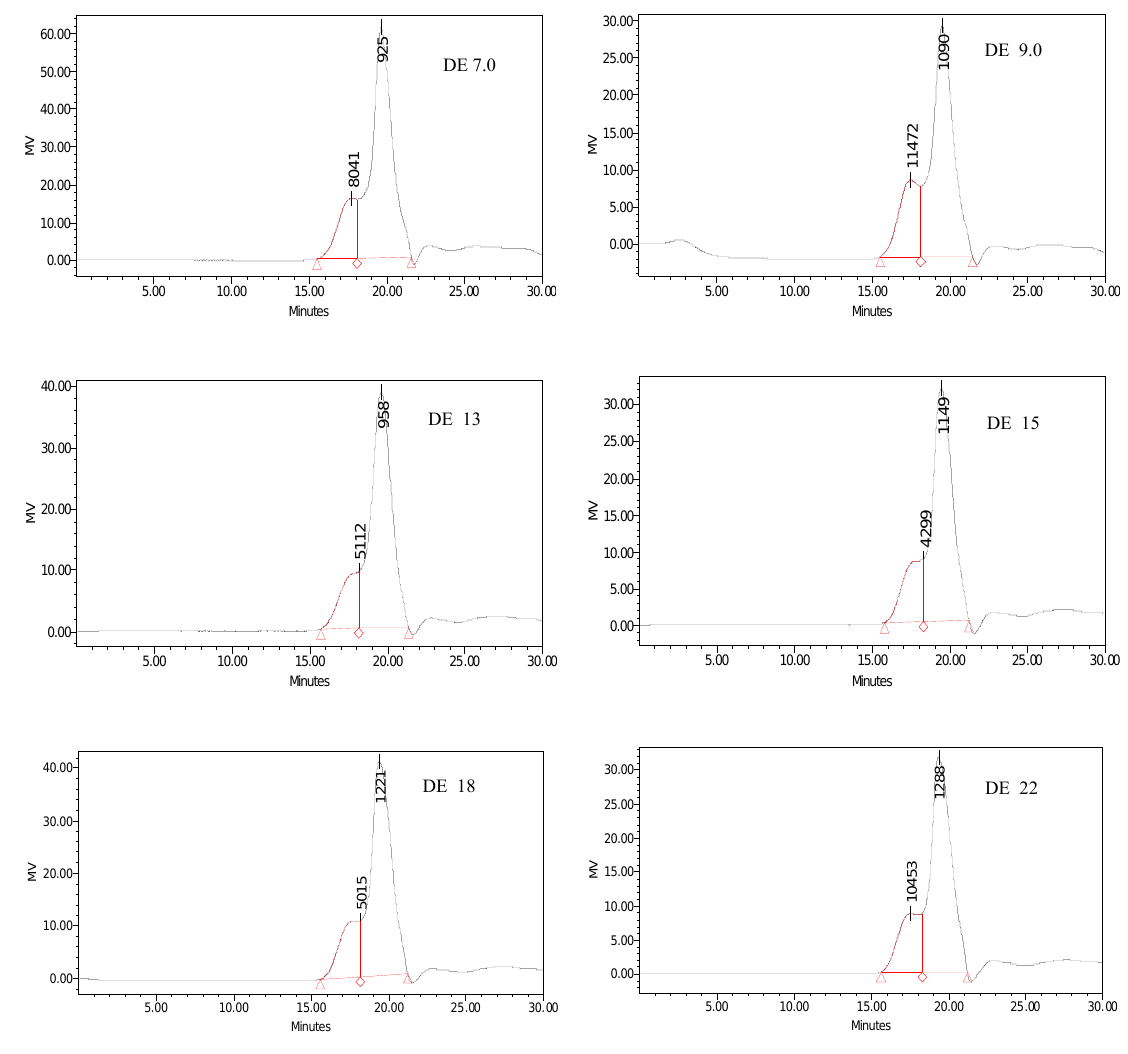
Figure 5. Molecular weight distribution of dextrins with different DE